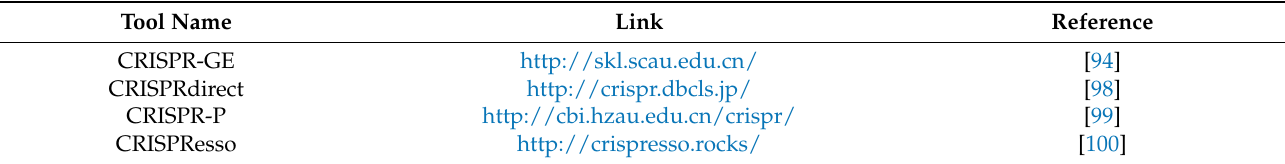
Table 3. Available bioinformatics tools for sgRNA